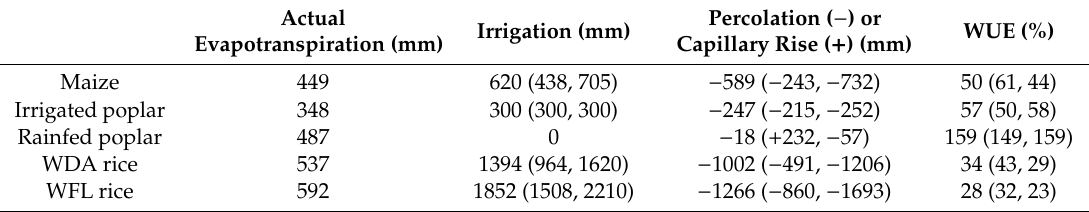
Table 4. Average water balance terms resulting from simulations and WUE of the agricultural area referred to the di ff erent land use types calculated for the cropping season (15 April–15 September) for the period 2013–2016. WUE averaged over areas characterized by shallow and deep GWLs are reported in brackets; average rainfall value was 320 mm. Percolation ( − ) or Actual WUE (%) Irrigation (mm) Capillary Rise ( + ) (mm) Evapotranspiration (mm) Maize 449 620 (438, 705) − 589 ( − 243, − 732) 50 (61, 44) Irrigated poplar 348 300 (300, 300) − 247 ( − 215, − 252) 57 (50, 58) Rainfed poplar 487 0 − 18 ( + 232, − 57) 159 (149, 159) WDA rice 537 1394 (964,